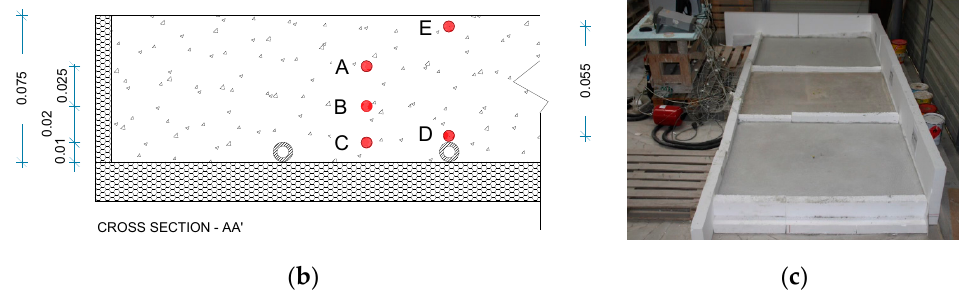
Figure 2. Experimental test setup: ( a ) full layout; ( b ) cross-section with thermocouples’ detailed po- sition; ( c ) full view of the test setup real installation (dimensions in metres).